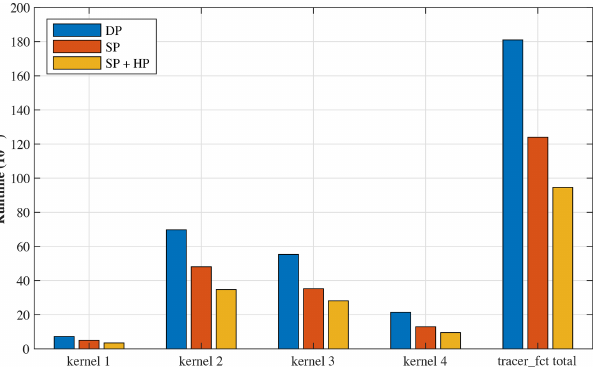
Figure 12. The strong scalability results, scaling from 2129920 to 27988480 cores with 2km, 1km and 500m